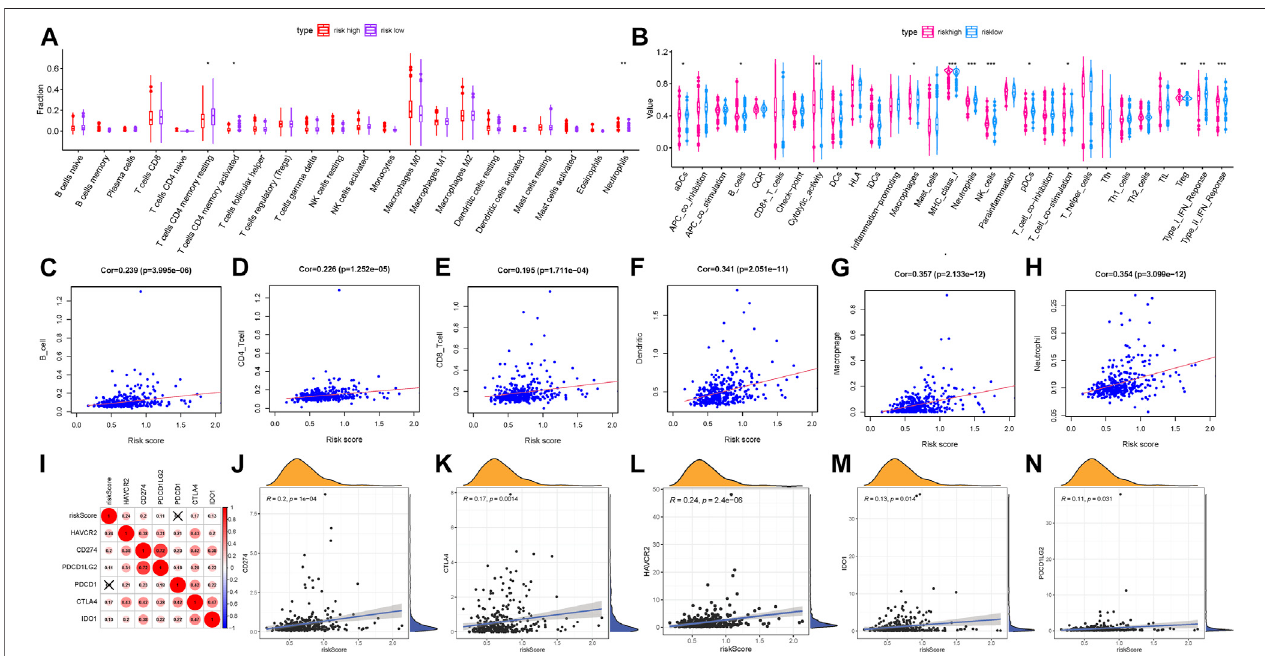
FIGURE 6 | Correlation of the prognostic risk score with TIME characterization of HCC. (A) Results of the CIBERSORT algorithm of two risk subgroups. (B) Comparison of ssGSEA analysis in two risk score subgroups. (C) Relationship between this signature and B cells. (D) Relationship between this signature and CD4 T cells. (E) Relationship between this signature and CD8 T cells. (F) Relationship between this signature and dendritic cells. (G) Relationship between this signature and macrophages. (H) Relationship between this signature and neutrophils. (I) Correlation analysis between immune checkpoint inhibitors (CD274, PDCD1, PDCD1LG2, CTLA4, HAVCR2, and IDO1) and the prognostic risk signature. (J) Correlation between the prognostic risk signature and CD274. (K) Correlation between theprognosticrisksignatureand CTLA4. (L) Correlation betweentheprognostic risksignatureandHAVCR2. (M) Correlationbetweentheprognosticrisksignatureand IDO1. (N) Correlation between the prognostic risk signature and